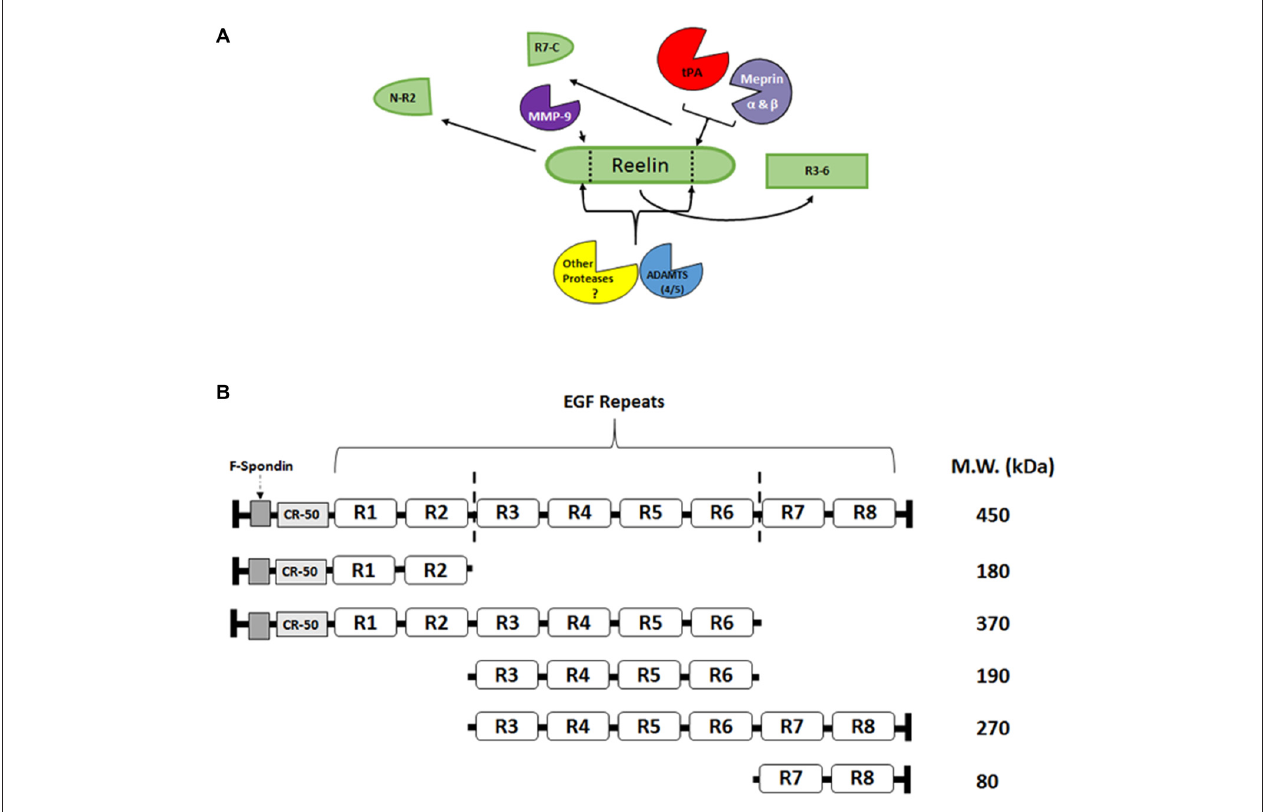
FIGURE 2 | Reelin proteolysis in the adult brain. (A) Full length Reelin is released into the extracellular space by GABAergic interneurons in the adult brain. This full length Reelin is enzymatically cleaved between epidermal growth factor (EGF) repeats 2–3 (R2-R3) and 6–7 (R6-R7; indicated by dotted lines; A,B ), by a number of different enzymes. For example, tissue plasminogen activator (tPA), Meprin α and β have been shown to cleave Reelin between R6 and R7 (Kohno et al., 2009; Krstic et al., 2012; Trotter et al., 2014; Sato et al., 2016), while matrix metalloproteinases (MMP)-9 cleaves Reelin between R2 and R3 (Krstic et al., 2012). The ADAMTS 4 and 5 have been shown to cleave Reelin at both sites (Hisanaga et al., 2012; Krstic et al., 2012). Other, yet to be identified proteases, are also potentially involved in Reelin processing. (B) Full length Reelin (450 kDa) is cleaved by a number of enzymes which result in the production of five fragments that range from 370–80 kDa. The R3-R6 fragment [included in the full length Reelin (450 kDa), 370 kDa, 190 kDa, and 270 kDa fragments] has been shown to bind to the lipoprotein receptors, ApoER2 and VLDLR (Jossin et al., 2004). The N-R2 fragment (180 kDa) has been shown to bind to alpha 3 beta 1 -integrins (Dulabon et al., 2000) and neuronal migration has been shown to be disrupted in vivo by the CR-50 antibody (Nakajima et al., 1997). The C-terminal region (R7-C; 80 kDa) has been shown to be involved the secretion of Reelin, as well as its proper folding (de Bergeyck et al., 1997; Jossin et al., 2004), and for downstream signaling efficacy (Nakano et al.,